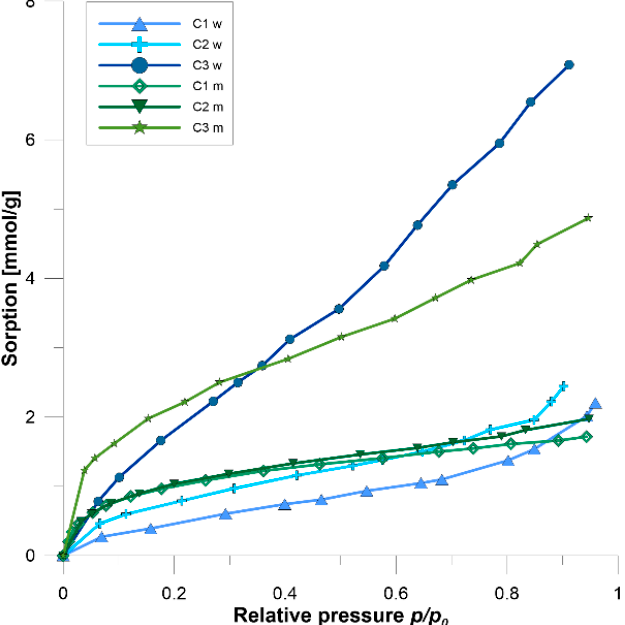
Figure 4. Sorption isotherms of water vapour (Ci w) and methanol vapour (Ci m) on coals C1, C2, C3.